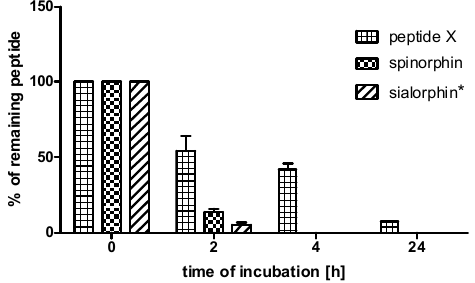
Figure 1. The stabilities of sialorphin, spinorphin and their analog (peptide X ) in human plasma. The means of the % of remaining peptide with a standard deviation are presented. * data published in Sobocinska et al.